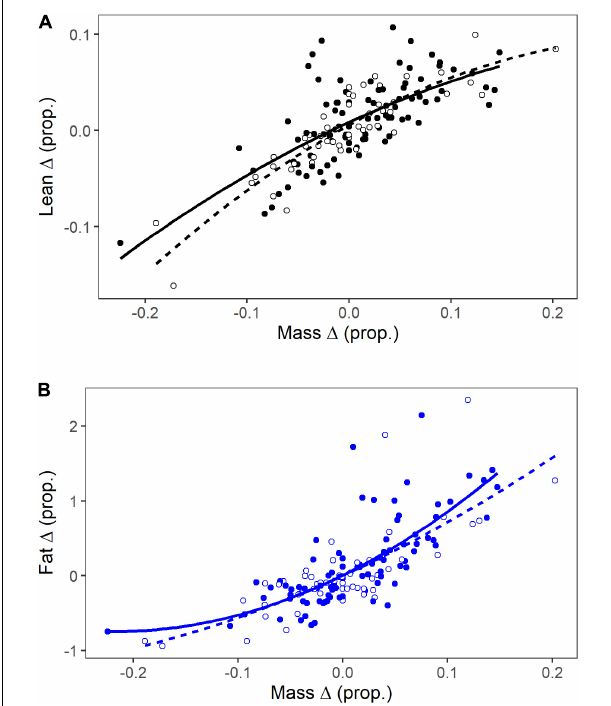
FIGURE 7 | Proportional change in lean mass (A) and fat mass (B) in relation to proportional change in total mass for recaptured songbirds at Long Point, Ontario. Shown are the quadratic relationships for all birds omitting White-throated Sparrows (solid symbols and lines) and White-throated Sparrows alone (open symbols and dashed